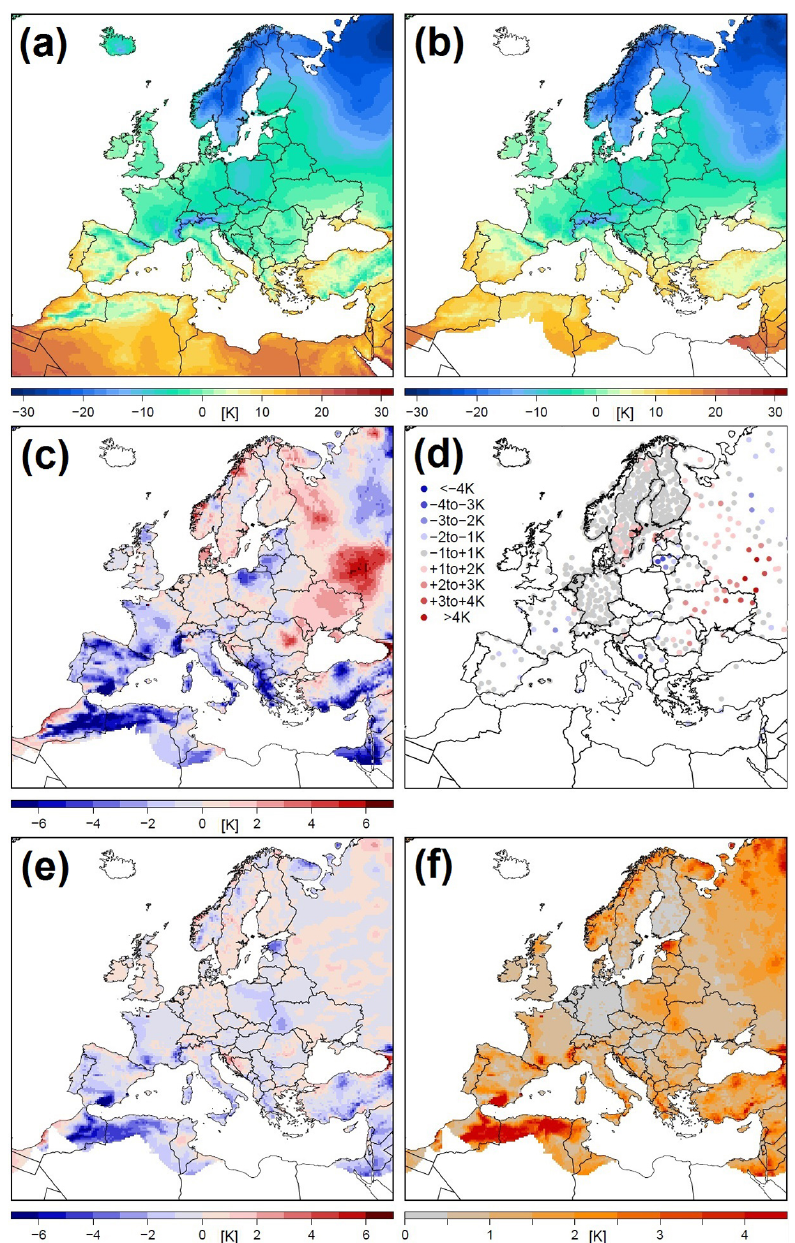
Figure 20. Comparison of daily temperature grid data from DecReg and E-OBS for January 2010: (a) DecReg daily mean